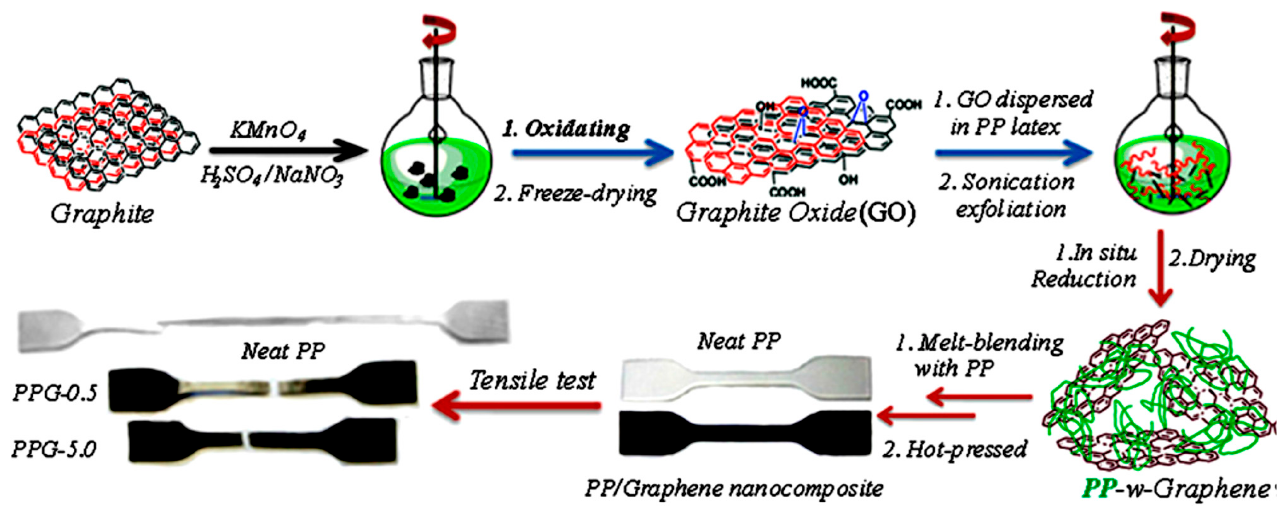
Figure 3. Schematic of polypropylene/graphene nanocomposite fabrication. PP = polypropylene; G = graphene; PPG = polypropylene/graphene. Reprinted with permission from [76]. 2011, Elsevier. Table 1. Mechanical properties of polypropylene/graphene oxide nanocomposites with various loadings. PP = polypropylene; YS = yield strength; TS = tensile strength; %YS = percent increment of yield strength. Reprinted with permission from [76]. 2011, Elsevier.